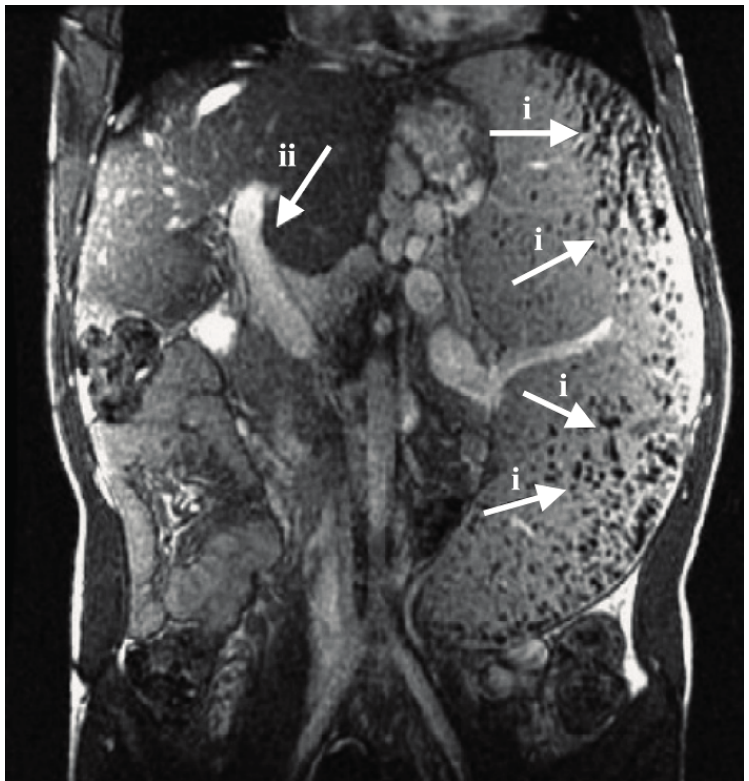
Figure 10. MRI: Gamma-Gandy bodies (siderotic nodules) pointed by arrows labelled “i” in the spleen of a patient diagnosed with hepatosplenicschistosomiasis. Arrow labelled “ii” shows the portal vein. Reproduced with permission [112].